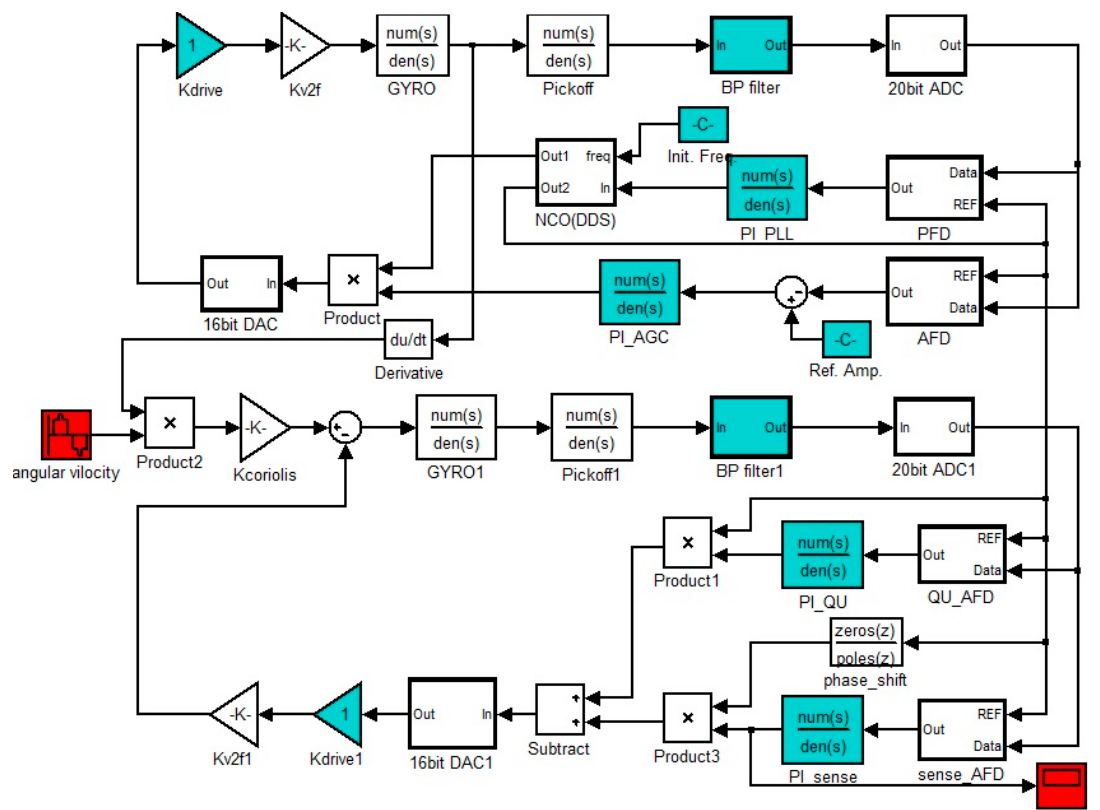
Figure 3. Original mechatronics model for DRG with a configurable ASIC.